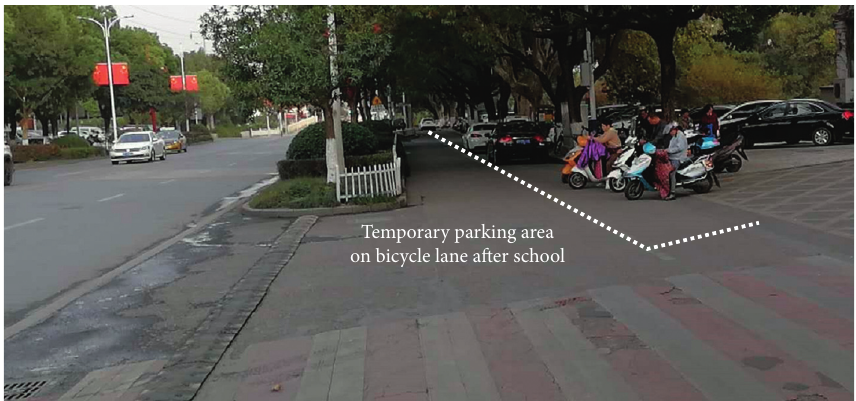
Figure 12: Adjustment in link 3 around the case school.